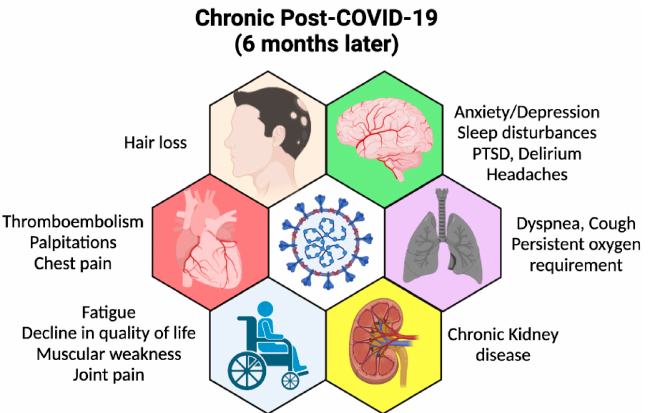
Figure 1. Long COVID-19 or post-acute sequelae. Schematic representation of persistent symptoms post-acute COVID-19. The figure was created using the BioRender.com website accessed on 15 March 2022.